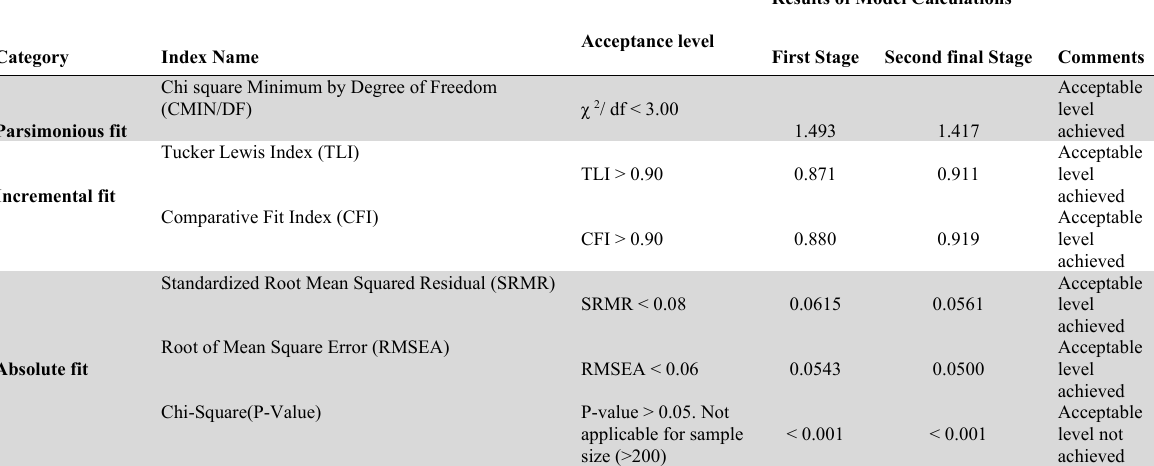
Results of Confirmatory Factor Analysis Overall Goodness of Fit Model